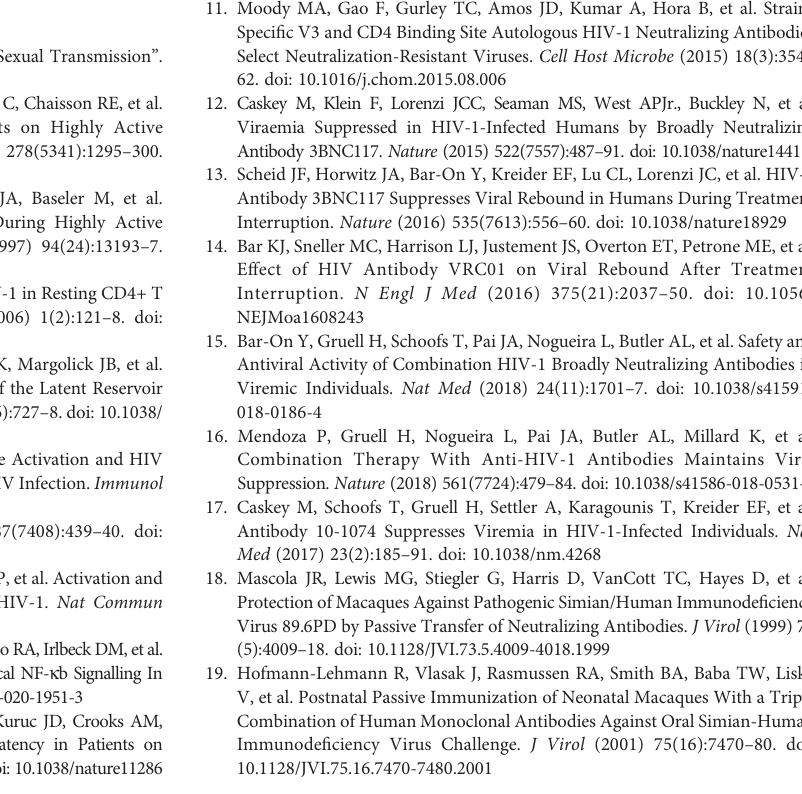
Supplementary Figure 1 | Modi fi ed quantitative viral outgrowth assay (QVOA). (A) Transmission of infection from reactivated SHIV-infected RM CD4+ T cells to A66 feeder cells. Primary CD4+ T cells from SHIV.CH505.375H-infected RMs were isolated and activated in vitro for 24 hours with anti-CD2/CD3/CD28 antibodies. The activated SHIV-infected RM CD4+ T cells were cultured alone or with autologous RM CD8+ cells for 48 hours in the absence or presence of DART molecules. On Day 4 the DART molecules were washed off and feeder A66 cells were added. Cells were split and media changed every 2-3 days. Supernatants collected at Day 4 and Day 9 were analyzed for SIV Gag p27 levels by ELISA to determine the amounts of SHIV virus that was produced. (B) p27 levels (ng/mL) in supernatants collected from cultures of activated SHIV-infected RM CD4+ T cells incubatedin theabsence ofautologousCD8cellsorDARTmolecules.Each symbol indicates an individual animal. Animal 14-97 is graphed separately due to the difference in scare supernatant p27 level. Supplementary Figure 2 | Cytokine release concomitant with cytolytic activity. Cultures of primary reactivated SHIV-infected RM CD4+ T cells alone or mixed with autologous RM CD8+ T cells were incubated without (No DART) or with DART molecules for 48 hours. Cytokines measured in supernatants included IL-1b, IL-6, IL-8, IL-12p40, IL-18, GM-CSF, IFN- g and TNF- a . Each symbol represents an individual animal; circles represent supernatants from CD4 cells and squares represent supernatants from mixtures of CD4 + CD8 cells. Limit of detection was set by the manufacturer at 1.6 pg/ml. ( C ) Statistical correlation between killing of infected cells by autologous CD8 cells in absence of DART molecules (refer to Figure 4B ) and levels of GM-CSF, IFN- g or TNF- a using two-tailed Pearson correlation coef fi cient with 95% con fi dence